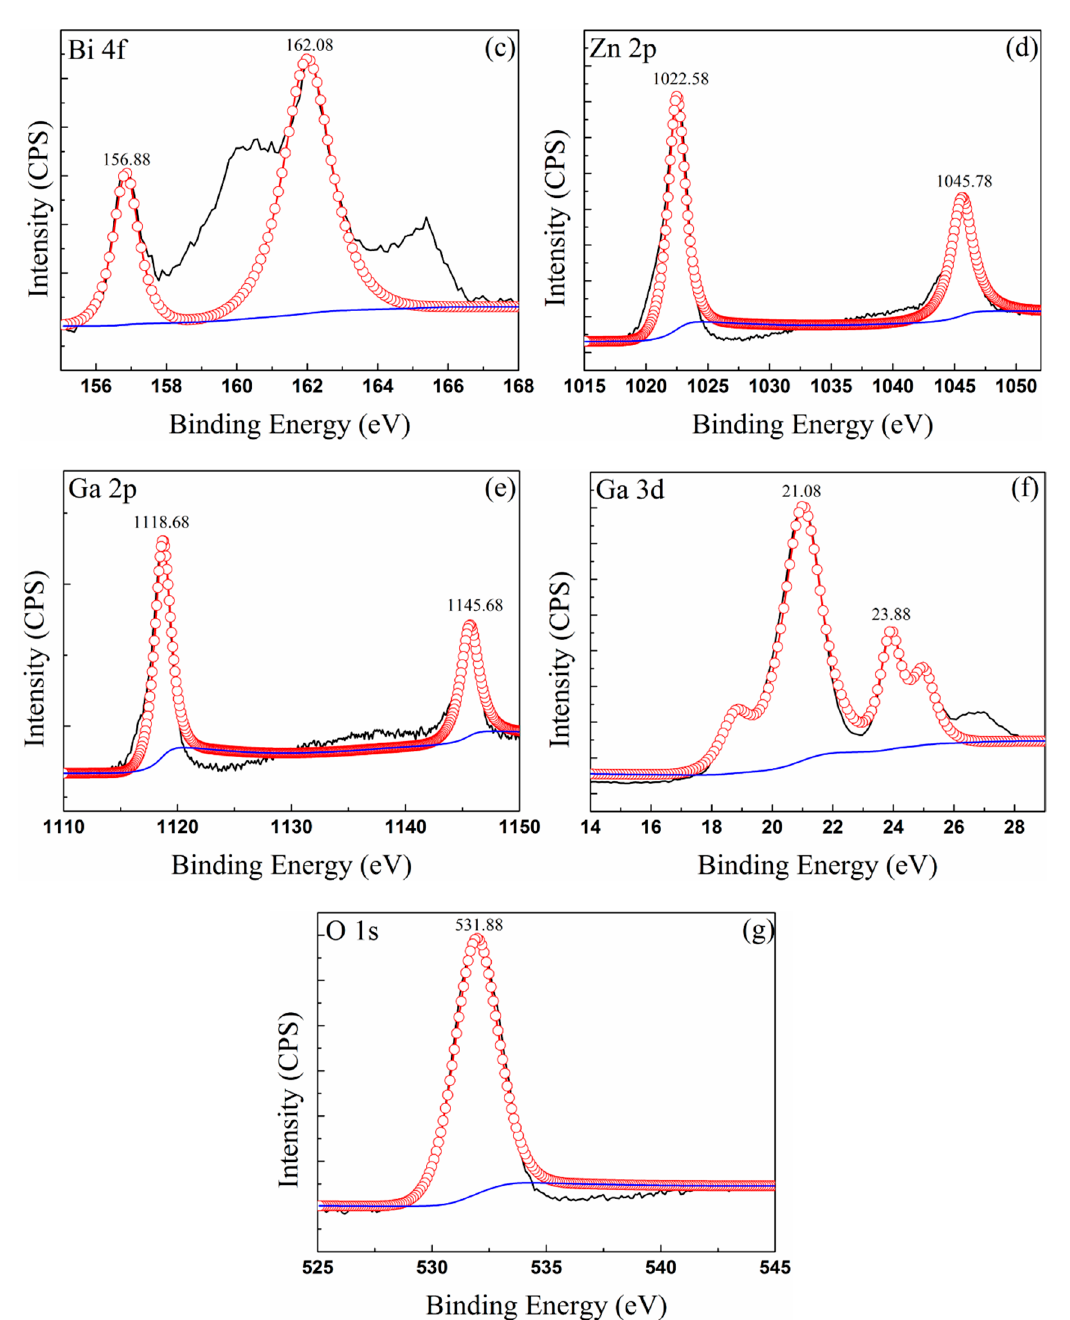
Figure 6. XPS spectra of the (Sn–50Bi–2Zn)–7Ga oxide surfaces ( a ), the relevant Sn ( b ), Bi ( c ), ZnO ( d ), Ga ( e ), Ga 2 O 3 ( f ), and O 1s ( g ).